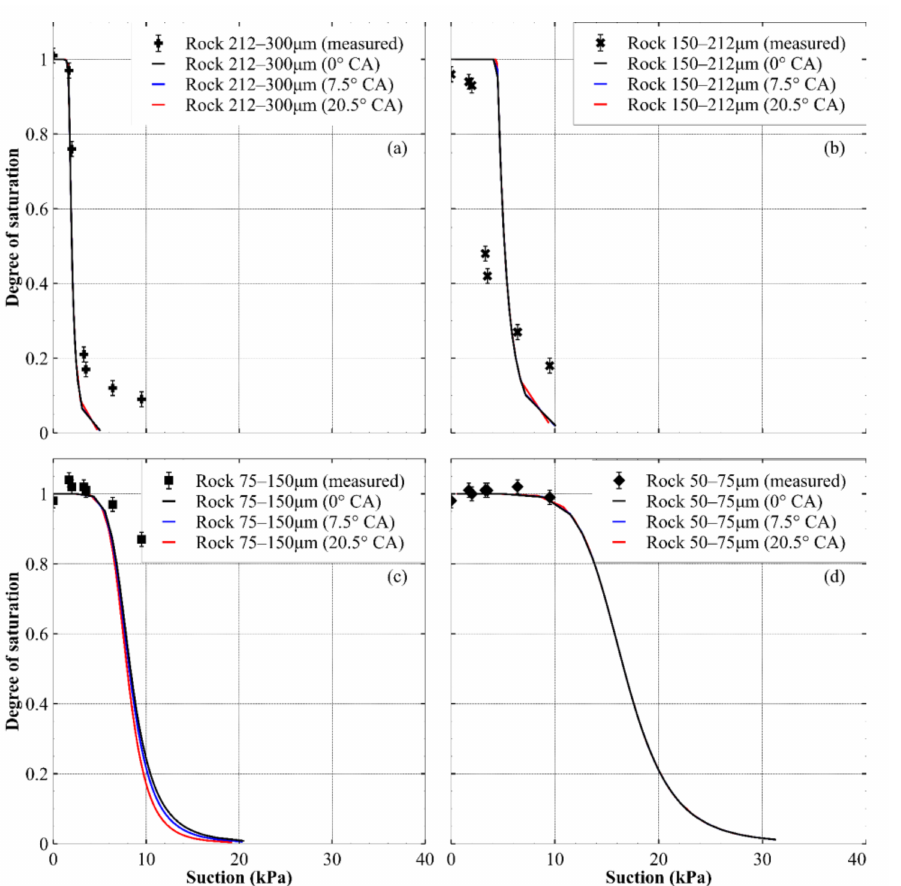
Figure 11. Predicted drying paths of the WRCs for crushed rock at different contact angles: ( a ) 212–300 µ m size fraction; ( b ) 150–212 µ m size fraction; ( c ) 75–150 µ m size fraction and ( d ) 50–75 µ m size fraction. For each prediction, CA values of 0 (black lines), CA mean − CA SD (blue lines) and CA mean + CA SD (red lines) were